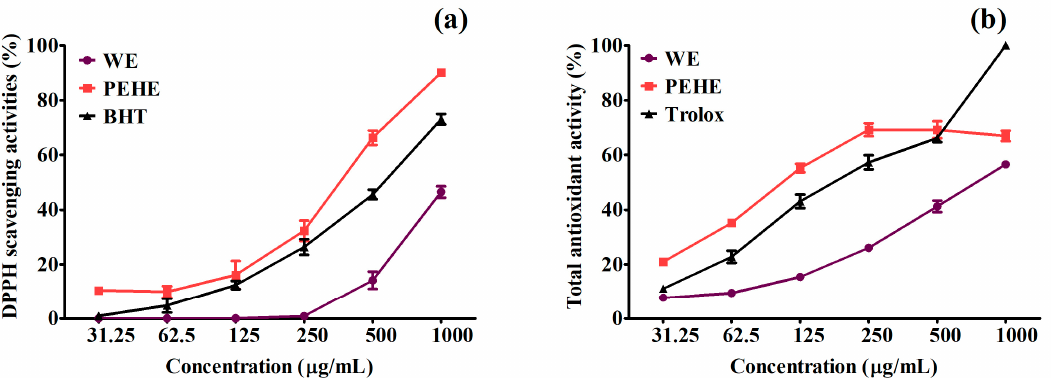
Figure 1. DPPH free radical ( a ) and ABTS radical cation ( b ) scavenging activities and IC 50 values for scavenging free radicals from PEHE and WE of hawthorn fruits. Results are expressed as percentage decrease of absorbance at 517 nm ( a ) and 734 nm ( b ) with respect to blank. BHT and Trolox were used as standards, respectively. Data are expressed as mean ± SD (n = 3). Table 2. The DPPH and ABTS radical scavenging activities of WE and PEHE from hawthorn fruits.